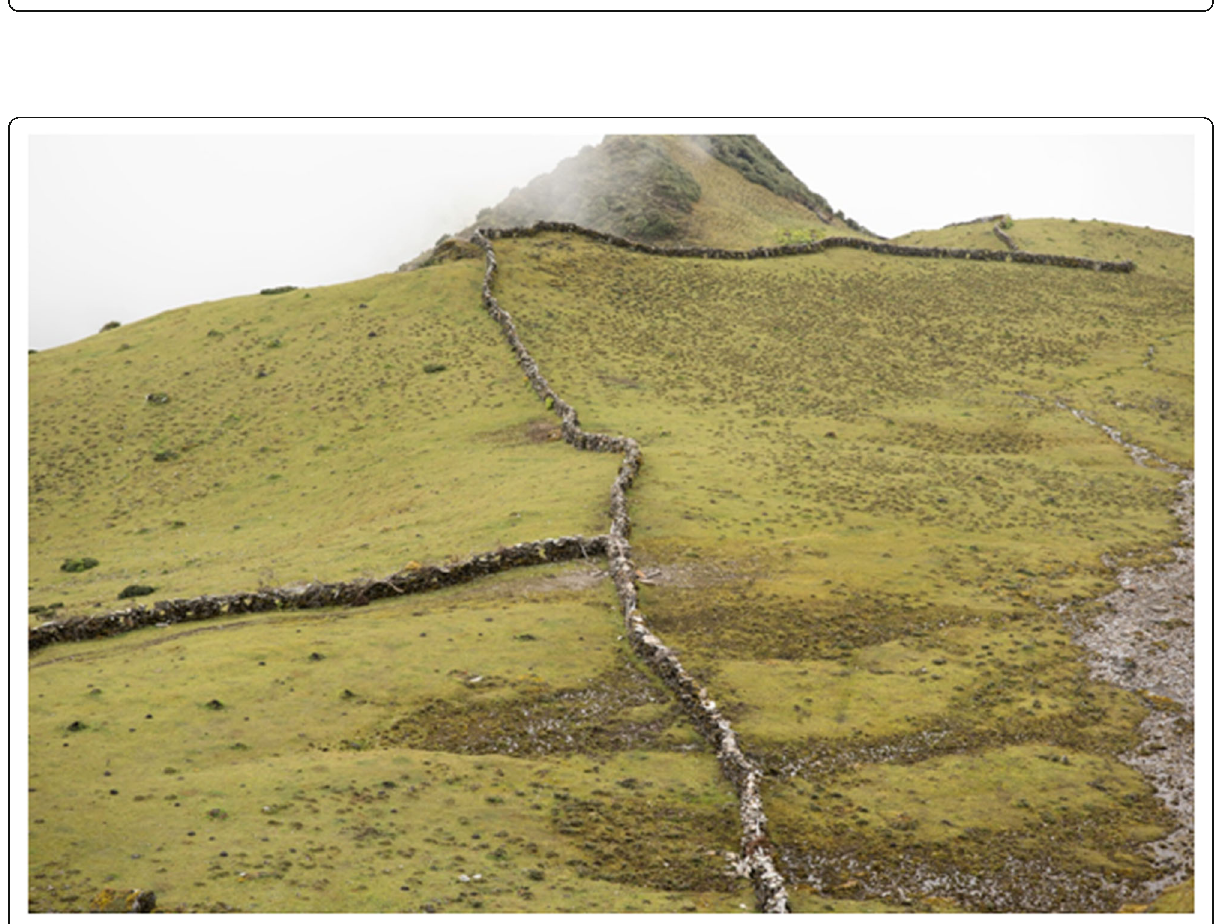
Figure 6 Herders ’ perception of purpose and management of the wall and fence. A To keep our cattle in as much as to prevent trespassing. B Ensure good forage growth. C Method of tsamdro management. D As a demarcation for tsamdro. I Seasonally. II Annually. III Whenever required. IV Do not renovate